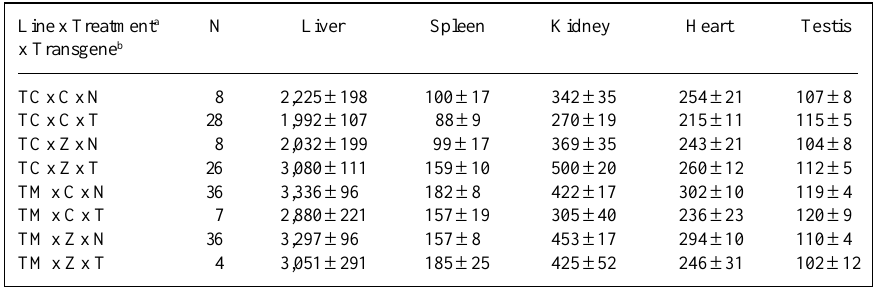
Table V - Least-squares means ± SE for line by treatment by transgene subclasses within lines TC and TM for absolute organ weights (mg). Line x Treatment a